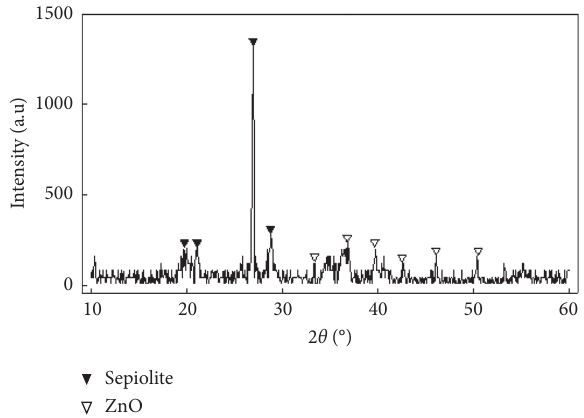
Figure 23: XRD pattern of the ZnO/sepiolite composite prepared by the hydrolytic precipitation method.